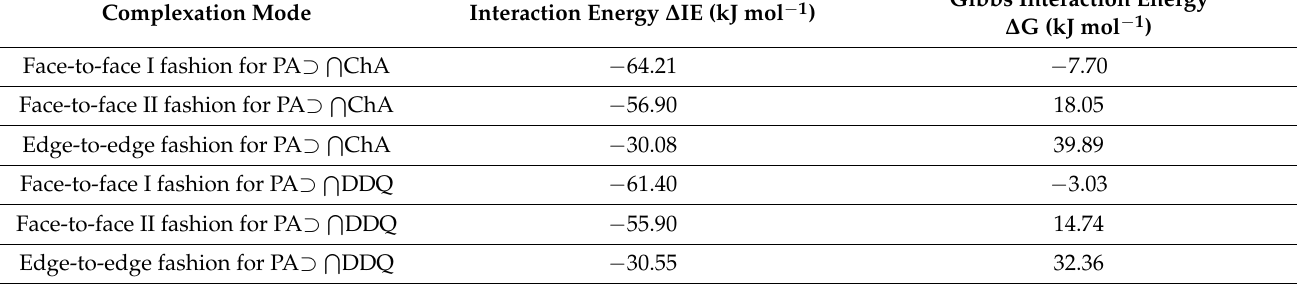
Table 4. DFT-calculated electronic binding interaction energies ( ∆ IE kJ/mole) and ∆ G (kJ/mole) for the PA complex with ChA and DDQ compounds at the ω B97XD/6-311++G(d,2p) level of theory in acetonitrile